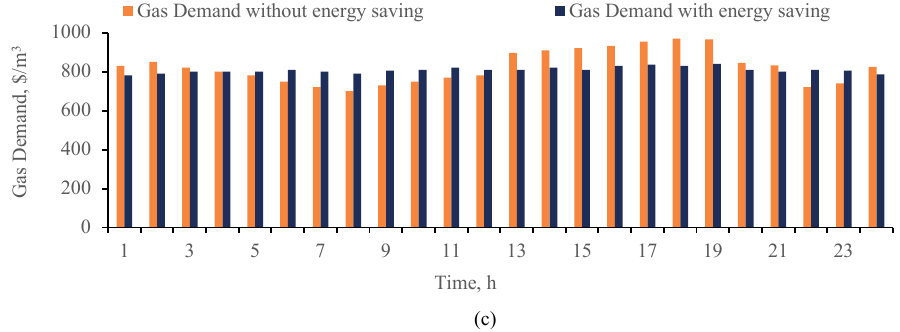
Fig. 6. Energy saving: (a) Electricity energy, (b) Thermal energy and (c) Gas energy.